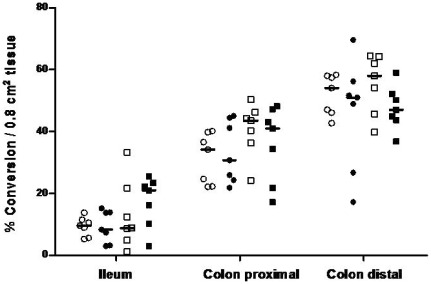
11β-hydroxysteroid dehydrogenase type 2 activity in rat intestine.Enzyme activity in total tissue was assessed by incubating fresh tissue sections in the presence of 3H-labelled substrate corticosterone. Metabolites were separated by thin-layer chromatography. Conversion rates of 3H-corticosterone (B) into 3H-11-dehydrocorticosterone (A) were calculated as percentage of dpm A/(dpm A+dpm B) and expressed per area of tissue. Sham normal salt: open circles, UNX normal salt: closed circles, sham high salt: open squares, UNX high salt: closed squares. The median for each group is given by a horizontal line (n = 7).